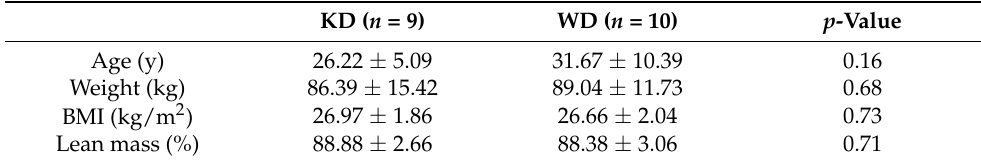
Table 1. Baseline characteristics of Ketogenic Diet (KD) and control western diet (WD)